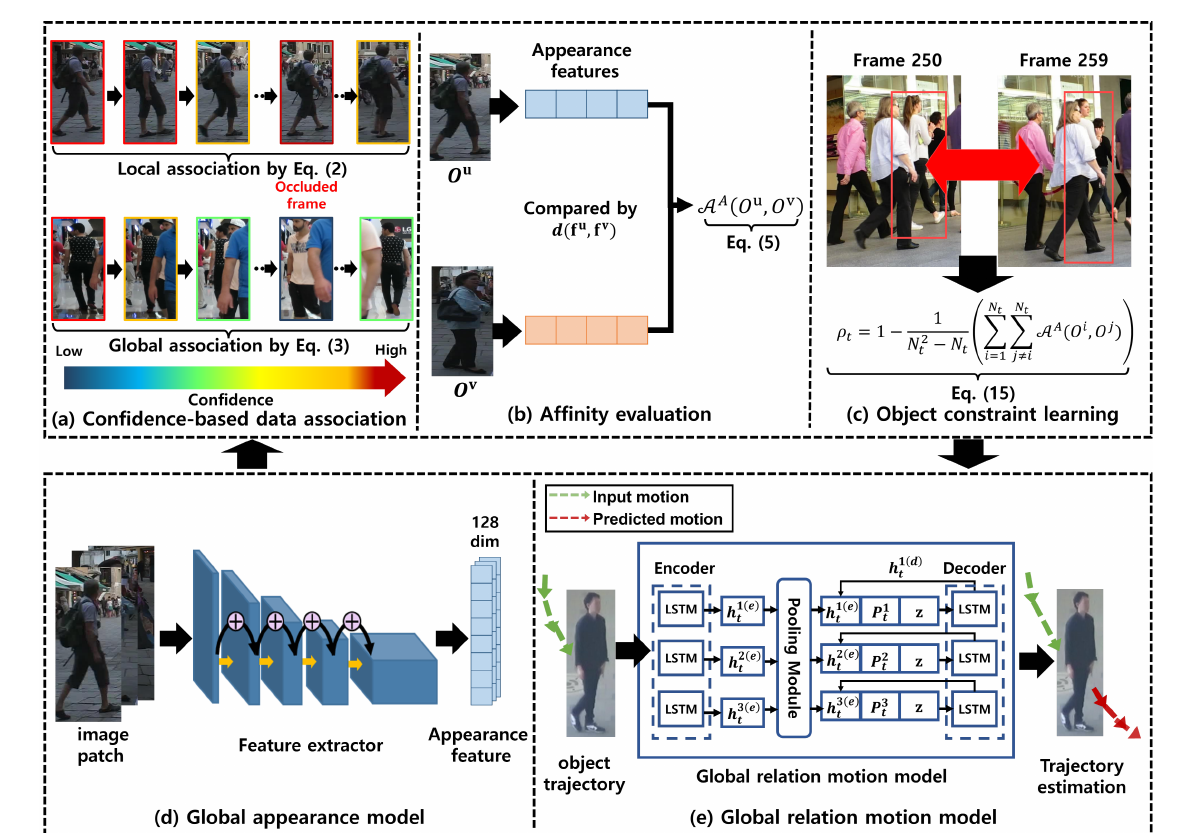
Figure 1. The proposed MOT framework based on our global models and object constraint learning algorithm. We describe our multi-object tracker in the upper box, and global models in the bottom box. Our multi-object tracker consists of three parts. In ( a ), we describe the confidence-based data association. During multi-object tracking, we calculate the affinity scores as depicted in ( b ). To de- termine a frame of updating our global appearance model, we exploit the object constraint learning algorithm as depicted in ( c ). We use our global appearance and motion models to improve the data association quality. Our global appearance and motion models are shown in ( d , e ),